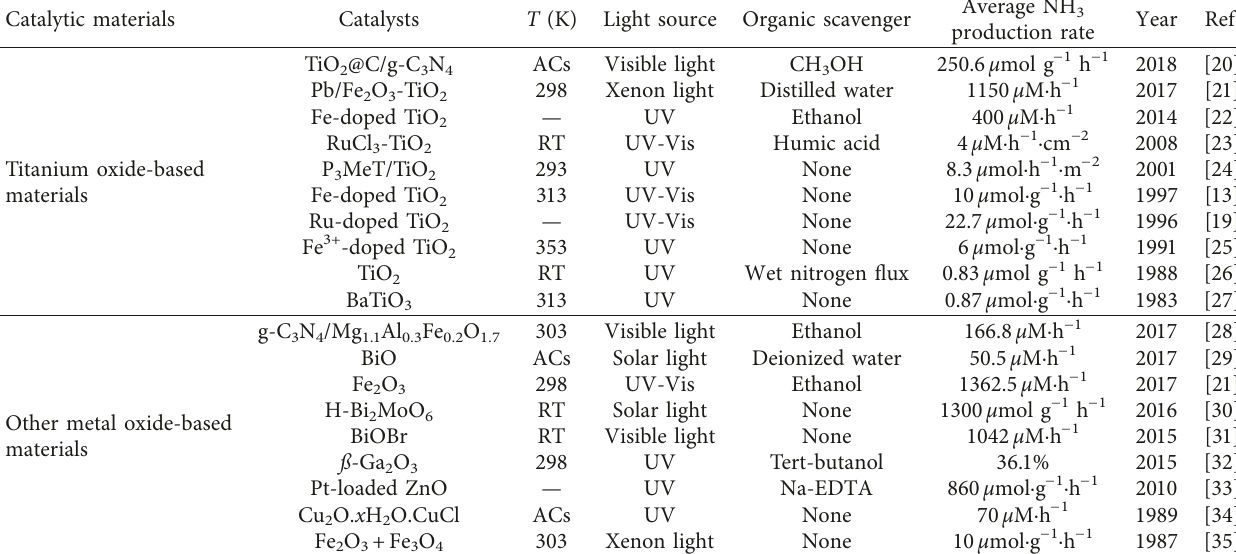
Table 2: Summary of metal oxide-based materials for photocatalytic reduction of N